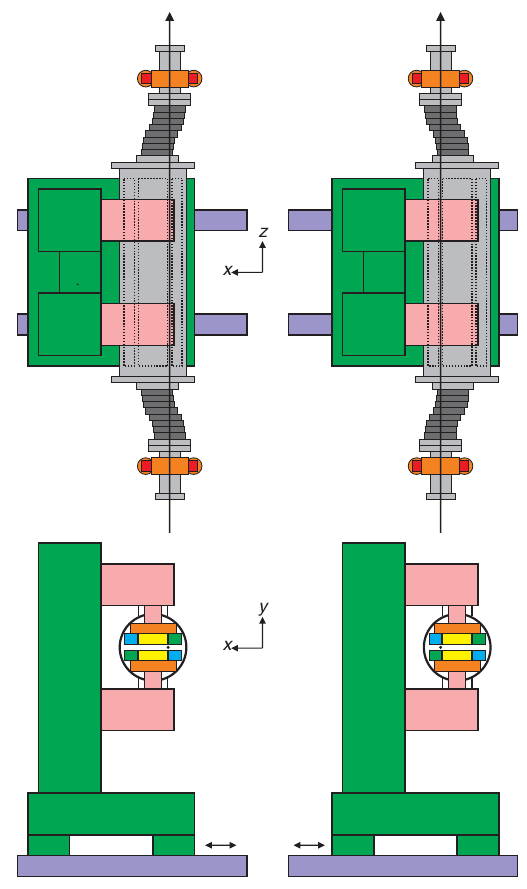
FIG. 4. Switching the helicity by translating the whole undulator.